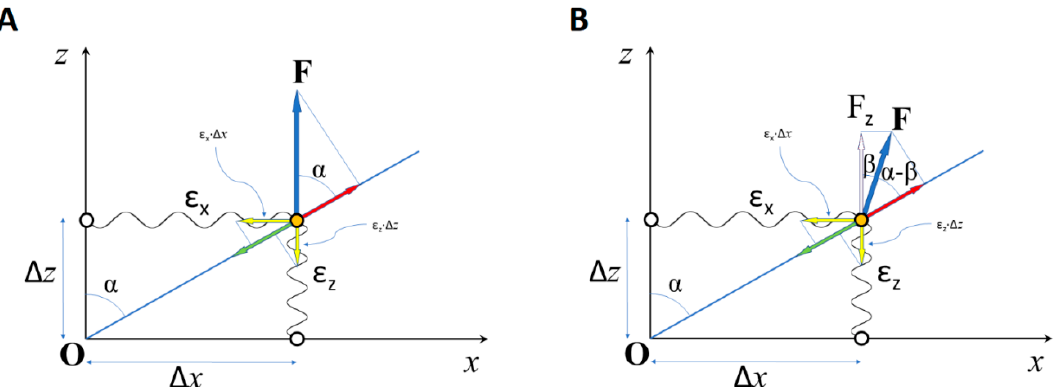
Figure A2. Schematic 2D representation of an elastic element with different stiffness values of ε x and ε z along the x and z directions, respectively. The blue line at angle α with the z axis represents the structural constraint of the movement of the tip of the element (orange circle) when a force F (blue arrow) is applied. Red arrows: component of the force F along the constraint; green arrow: restoring forces along the constraint, at equilibrium; yellow arrows: restoring forces along the x and z axis; white arrow: projection of F along the z direction. ( A ) Force F parallel to the z axis. ( B ) Force F at a generic angle β with the z axis.